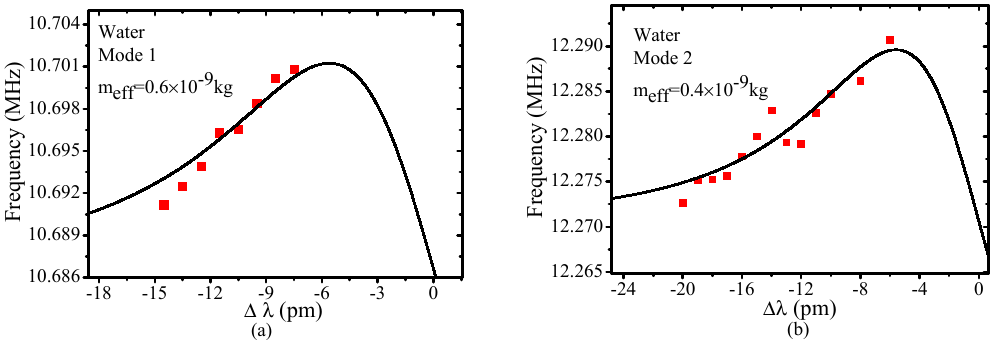
Figure 6. OSE of mode 1 ( a ) and mode 2 ( b ) as described in Figure 5. Solid red squares are the experimental data and the black lines are the simulated results, m eff of 0.6 × 10 − 9 kg and 0.4 × 10 − 9 kg are obtained.